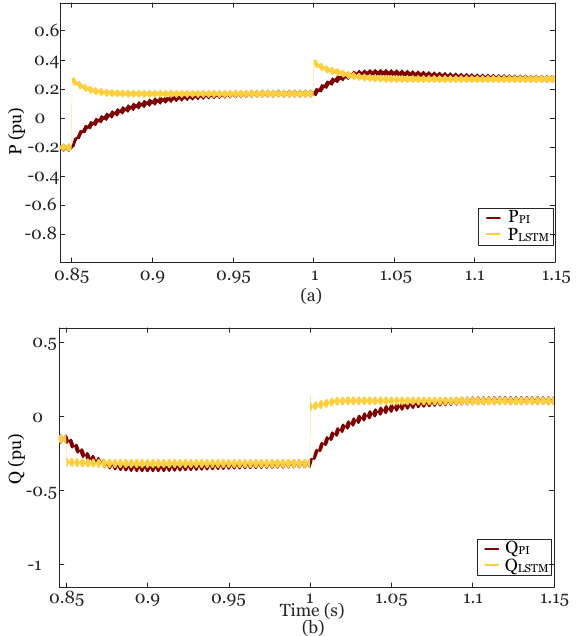
Figure 17. Real and reactive power response 20% decrease in the inductance of the grid filter. ( a ) Real power; ( b ) Reactive power.